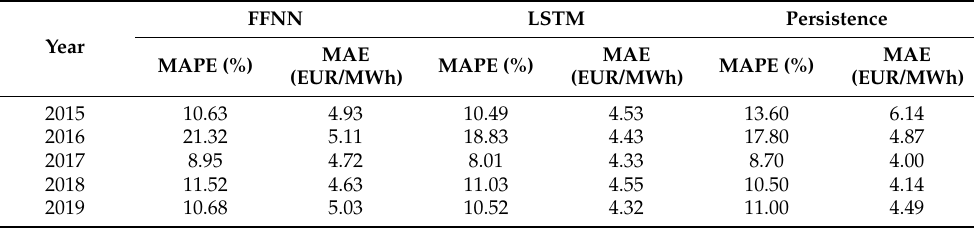
Table 7. Yearly forecasting error values of the FFNN, LSTM, and persistence